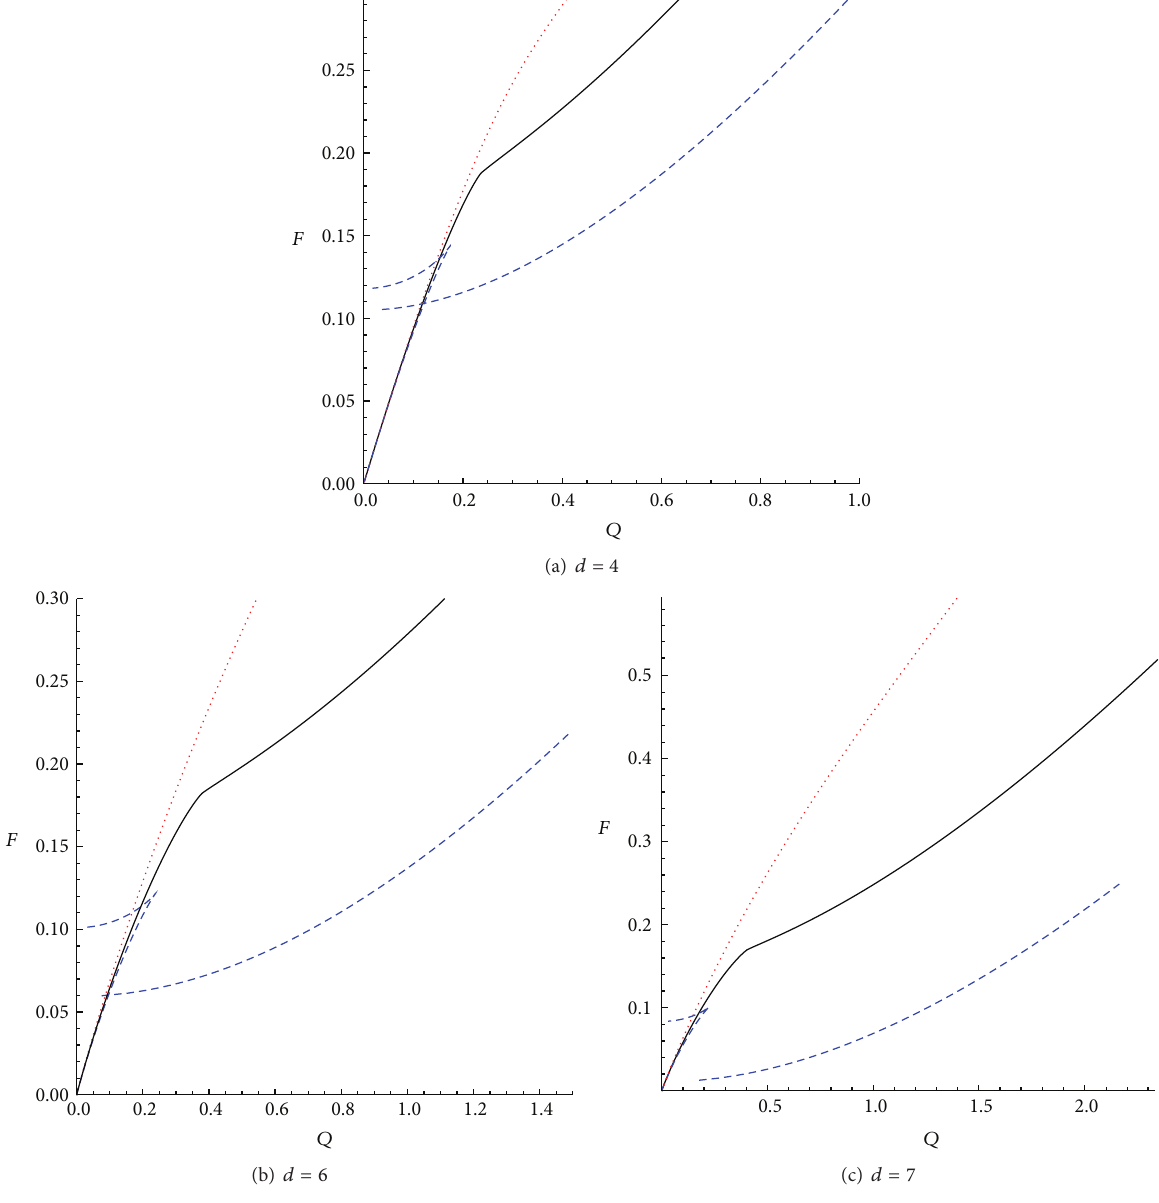
Figure 3: The 𝐹 - 𝑄 curves for 𝑑 = 4, 6, 7 , respectively. From top to bottom the curves correspond to the effective temperatures 0.7𝑇 loc , 𝑇 loc , and 1.4𝑇 loc